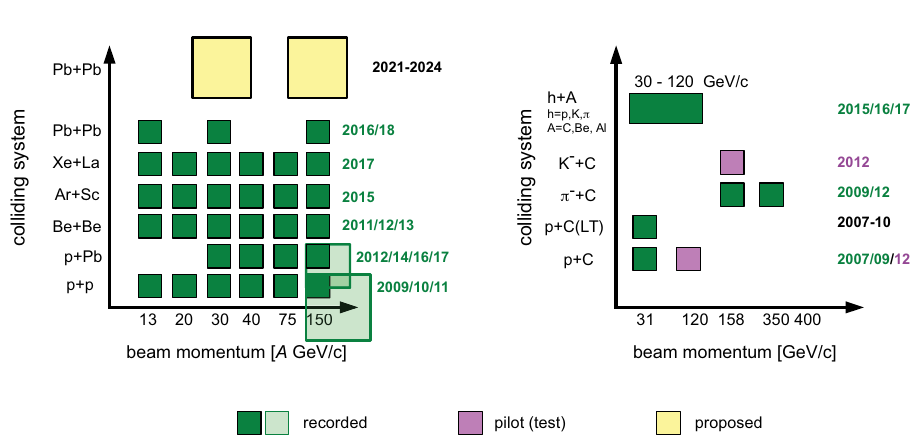
Figure 1: Reactions collected by NA61 / SHINE and proposed after CERN Long Shutdown 2 within both parts of the physics programme. Size of squares visualizes amount of data with typical sample size of few million events. Worth noting are measurements with meson beams.